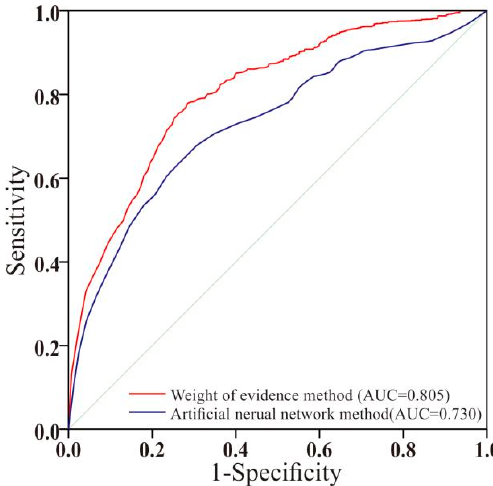
Figure 8. ROC curve graph about prediction results.